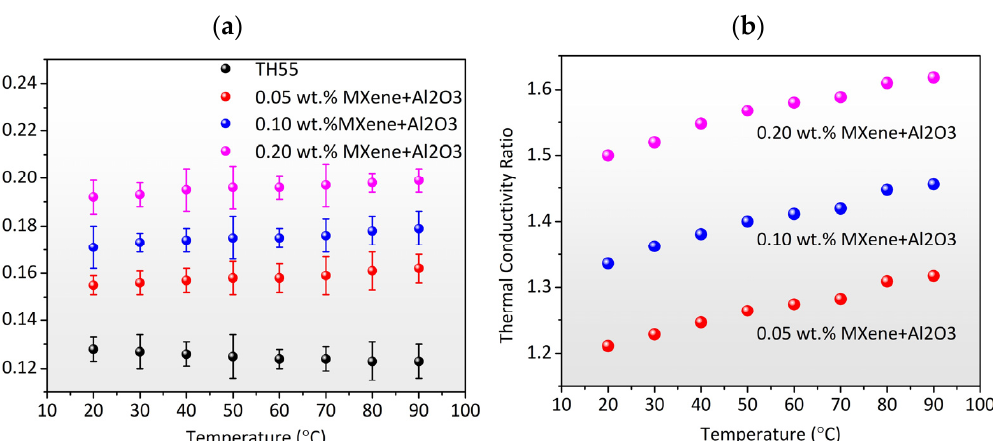
Figure 6. ( a ) Experimental thermal conductivity vs. temperature of Therminol55 and TH/MXene + Al 2 O 3 nanofluid at different concentrations; ( b ) Thermal conductivity ratio vs. temperature of the nanofluids at different concentrations of MXene + Al 2 O 3 .